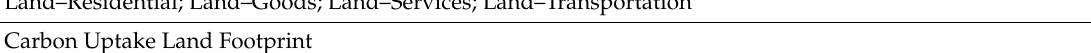
Table 1. Considered components for the derivation of consumption footprint.